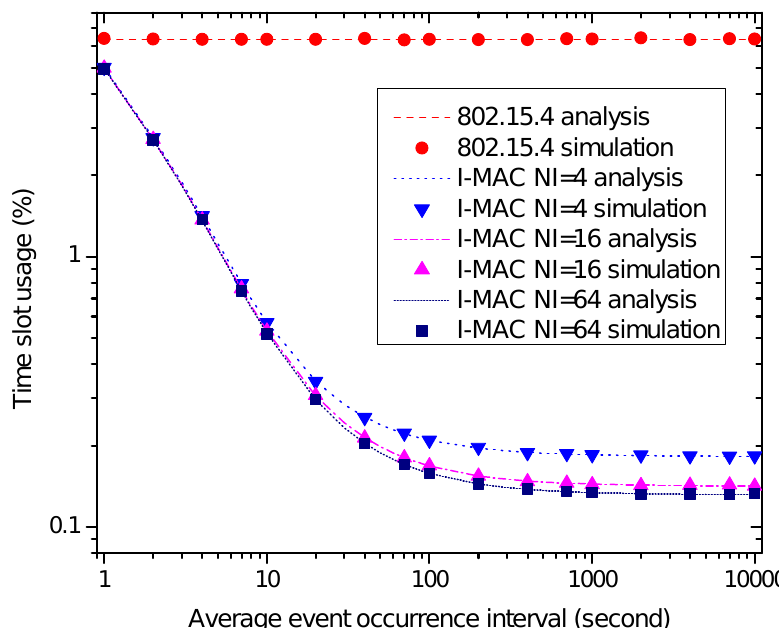
Figure 15. The effect of the average event occurrence interval on time slot